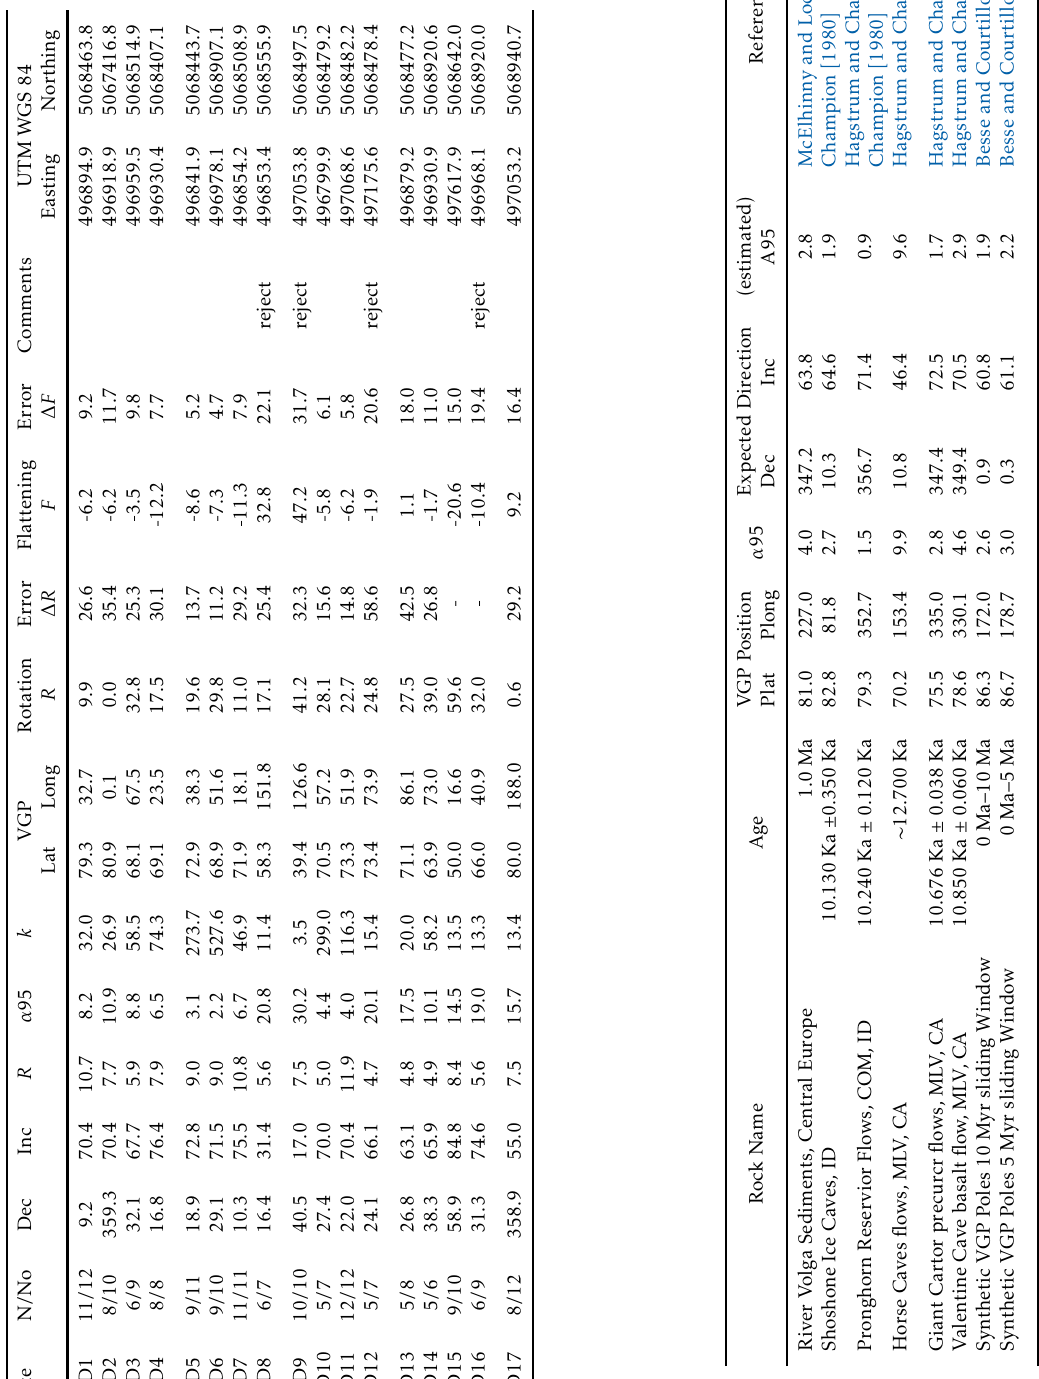
Table 1 – Paleomagnetic data from the Puy de Dôme, Auvergne, France. Explanation: Site, site name; N/No, number of specimens means used in site mean (N) to total number of specimen means at the section (No); Dec/Inc, site declination and inclination; R, resultant vector length; k, best estimate of (Fisher) precision pa- rameter; α 95, 95 % confidence interval of the estimated site mean direction assuming a circular distribution; VGP Lat/Long, latitude and longitude of the virtual ge- omagnetic pole; Rotation ( R ) and flattening ( F ) and as- sociated error estimates ( ± R, ± F) [Beck 1980; Demarest 1983] with respect to the average Quaternary expected field